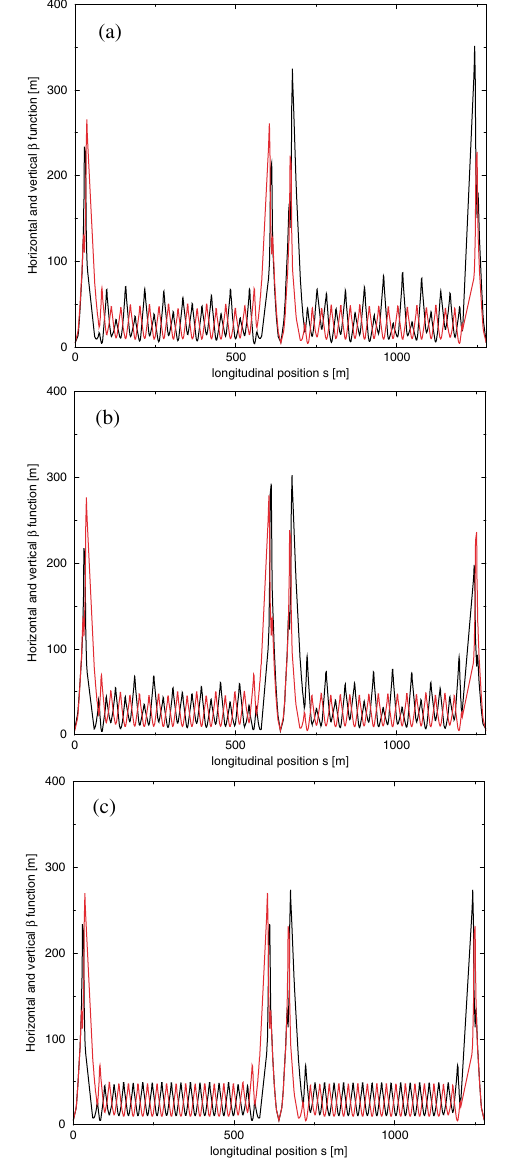
FIG. 3. (Color) Horizontal (black) and vertical (red) (cid:17) func- tions in one-third of the BLUE RHIC ring, before transition (top panel) and after (middle panel), for a (cid:4) (cid:1) (cid:11) 0 : 5 and a (cid:17) function of (cid:17) (cid:12) (cid:23) (cid:4) t points. The plot at the bottom depicts the regular situation with quadrupoles off. the (cid:4) t